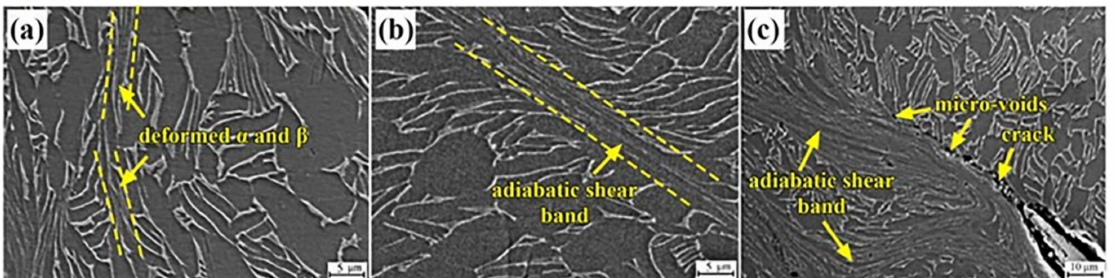
Figure 10. General view and magnified observations on the adiabatic shear band of the DM sample under the strain rate of 3000 s − 1 , ( a ) general view; ( b ) initiation; ( c ) expansion; ( d ) fracture.